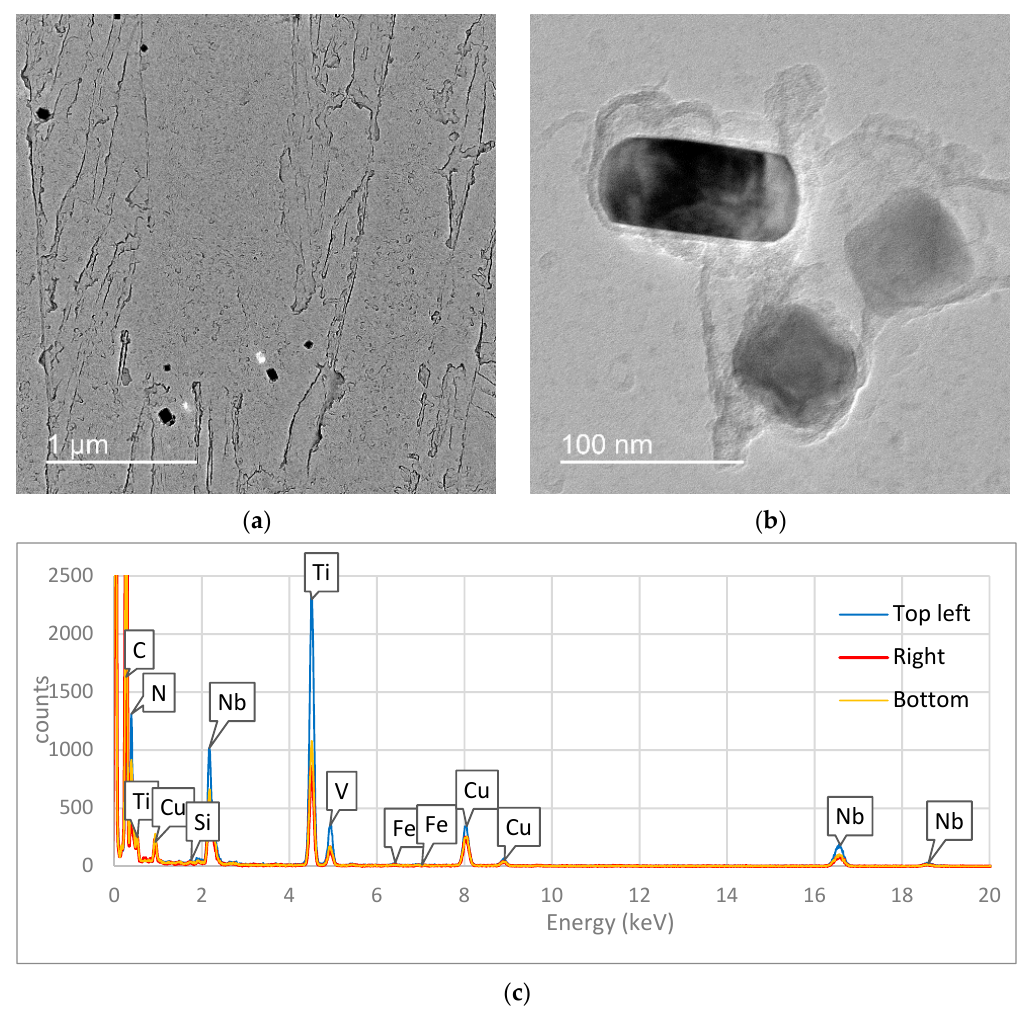
Figure 3. Transmission electron microscopy (TEM) micrograph examples ( a ) low magnification Low-Nb Steel austenitized at 1300 °C for 1 h; ( b ) high magnification from High-Nb Steel austenitized to 1300 °C for 1 h; ( c ) EDS spectra of particles in ( b ).